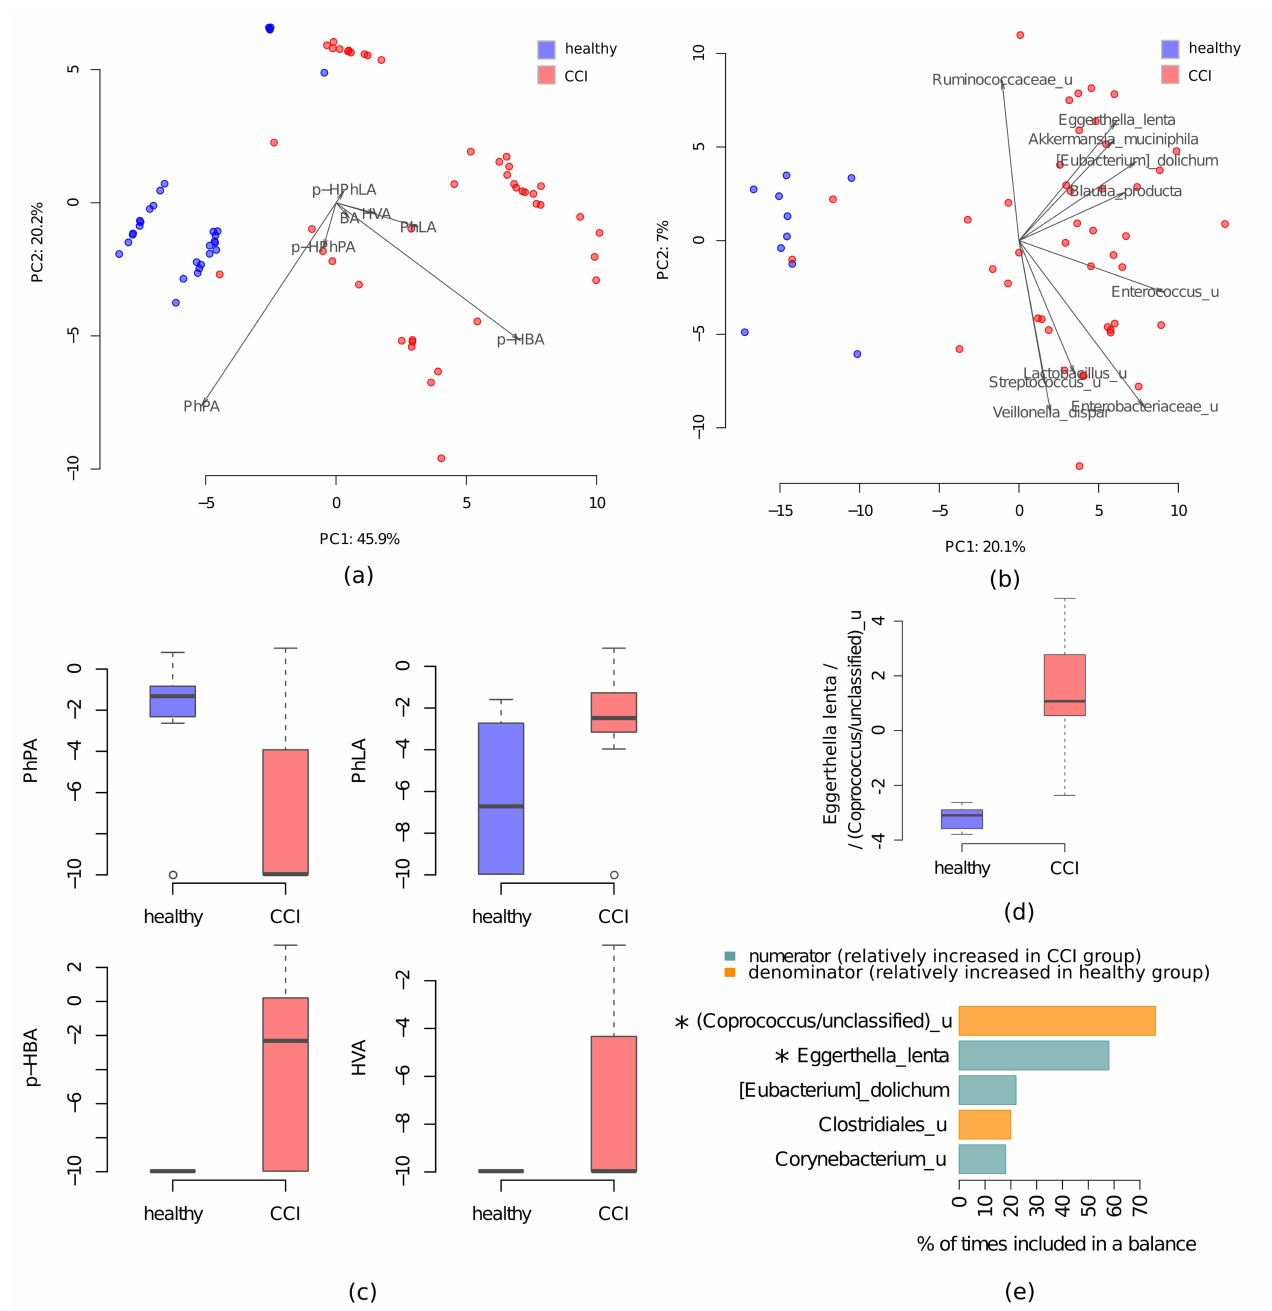
Figure 1. Comparison of the gut microbiome and serum metabolites between the healthy subjects and CCI patients. ( a ) PCA of metabolic profiles from the CCI patients (red dots) and healthy subjects (blue dots). ( b ) PCA of the CCI patients (red dots) and healthy subjects (blue dost) microbiome samples after clr transformation (Aitchison distance). Arrows show the top 10 taxa in terms of the variance explained by the axes (the arrow length is proportional to the explained variance, and the arrow angle reflects the distribution of this variance between the axes). ( c ) The levels of metabolites differentially abundant in the healthy subjects and CCI patients, the circles denote boxplot outliers ( d ) Values of microbiome balance at the level of species. ( e ) Reproducibility barplot for the 3 most frequent balance members during the cross-validation procedure: the blue bars correspond to the numerator members (part of the balance higher in patients) and orange—to the denominator members (part of balance higher in healthy subjects). Asterisks (*) denote taxa which are considered reliably associated with the group according to the balances-based approach (reproducibility of bacterial taxa > 50% and R 2 >